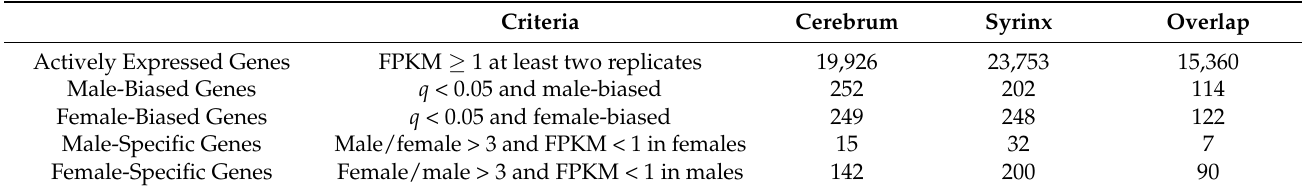
Table 3. Sex-biased gene expression in cerebrum and syrinx tissues.